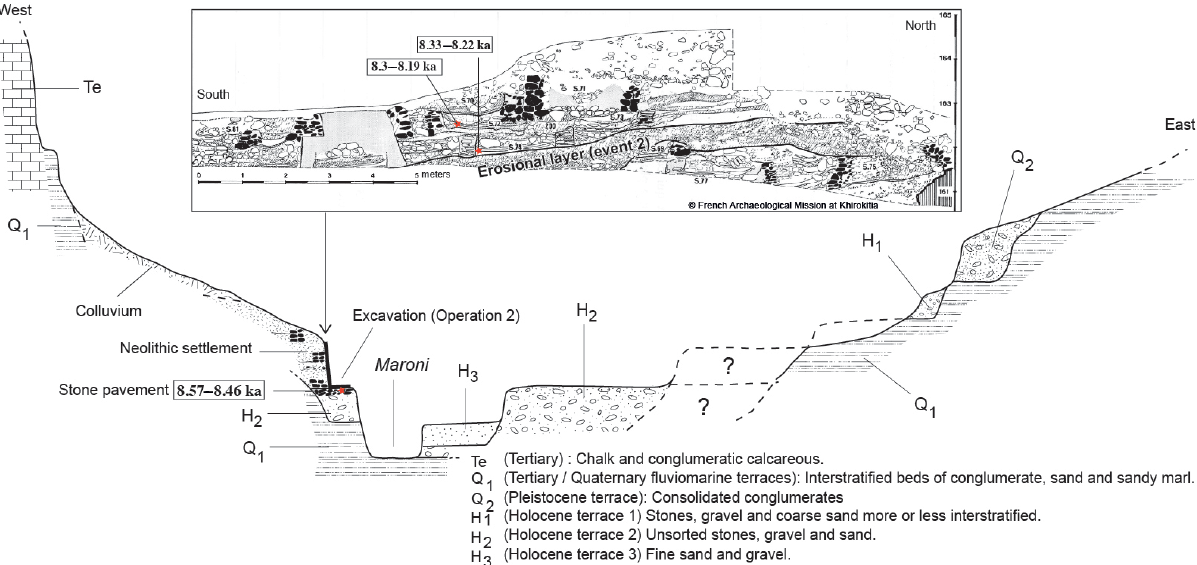
Figure 5. (a) Synthetic cross section of the Maroni Valley at the foot of the eastern slope of the site showing the depositional environments of the river and the situation of the studied archaeological sequence. The location of the section is shown in (b) , which is a north–south section through the occupation levels at the river border (operation 2) with the stratigraphic position of the second major erosional event.